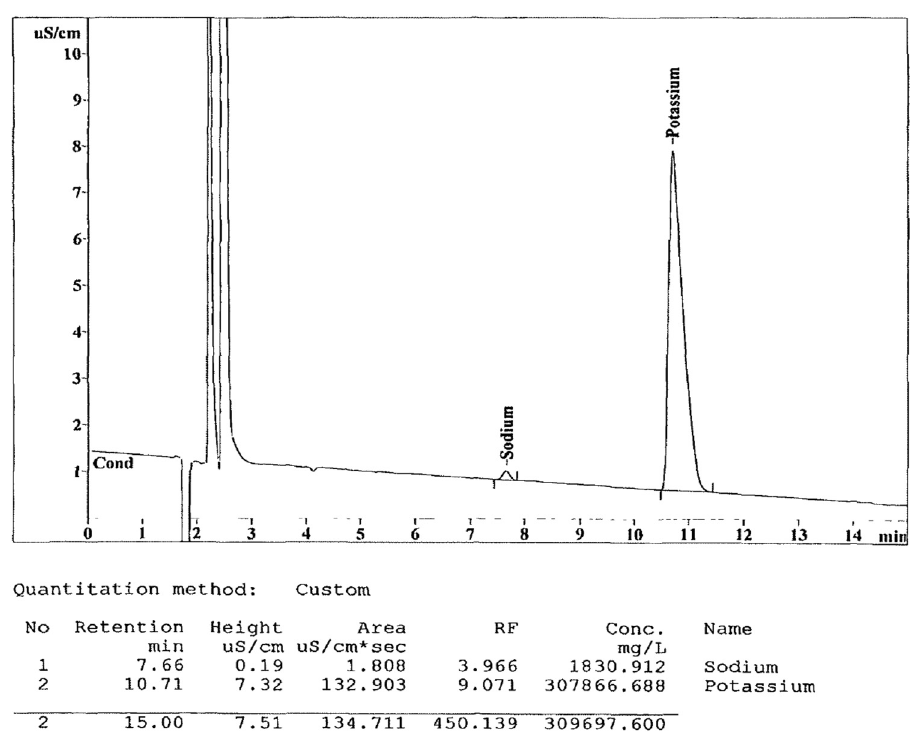
Figure A1: IC analysis of the by - product boric acid.